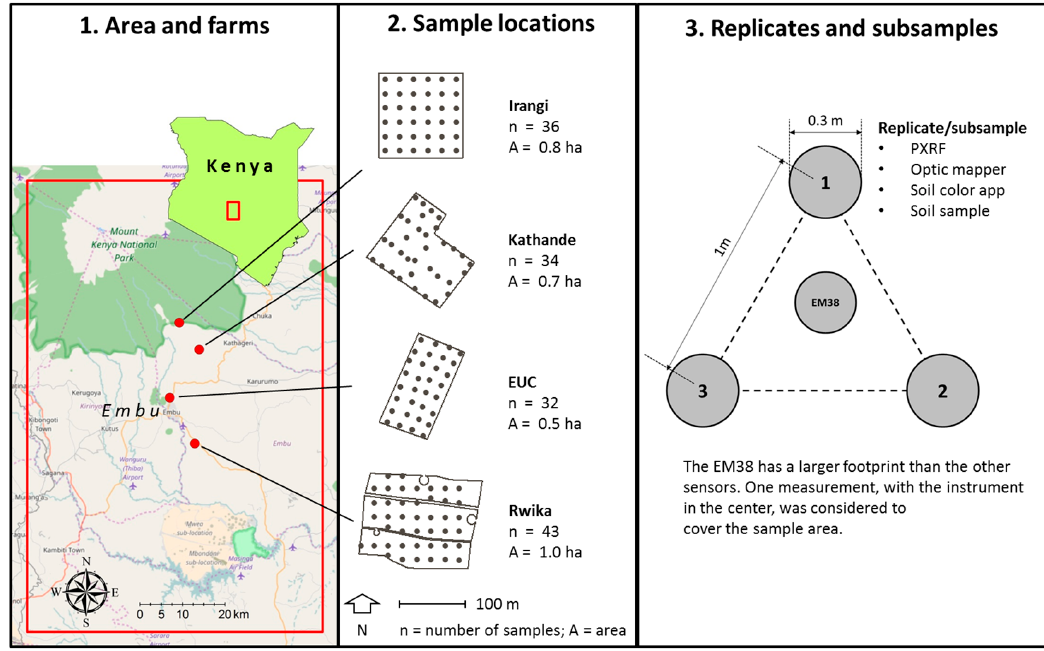
Figure 3. Sampling location and design. The map to the left shows where the four sites are located in Embu County, Kenya. The center panel shows where the samples were taken in each of the four sites and the panel to the right shows the geometry of replicates at the sample location. Subsamples are replicates. EUC = Embu University College. The background map is from OpenStreetMap (© OpenStreetMap contributors, data licenced on terms of ODbL 1.0, cartography licensed as CC BY- SA).